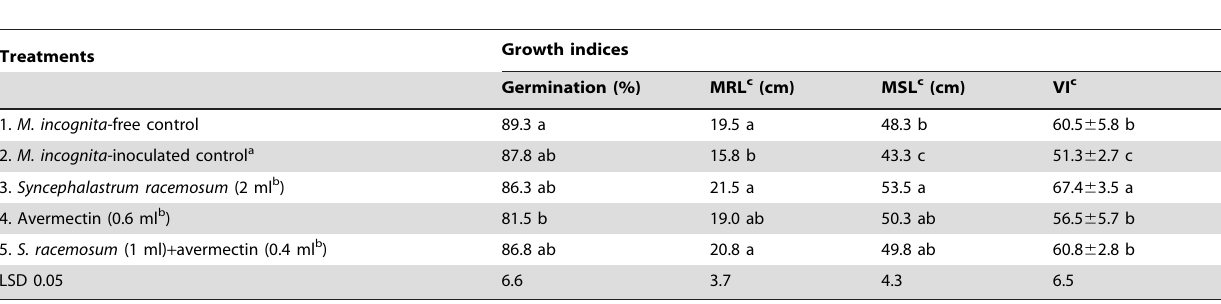
Table 1. Effect of biocontrol agents on seed germination and seedling vigor of cucumber plants in pots.